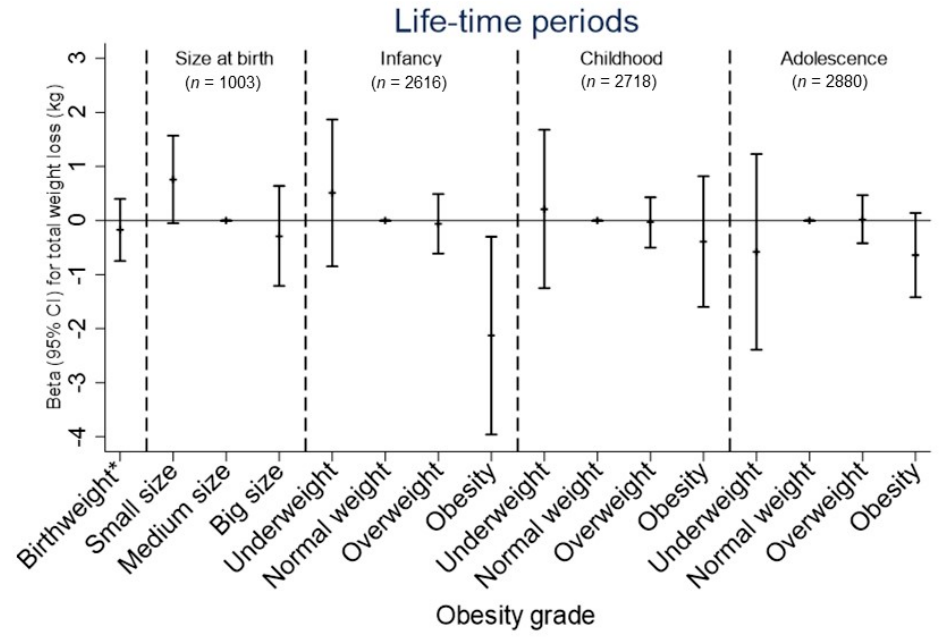
Figure 1. Associations between birth weight, size at birth, and personal life-course obesity grade with total weight loss (kg) in response to the intervention. Lines represent beta coefficient and 95% CI derived from linear regression models. All models adjusted for sex, age, nutritional clinic, year of assessment, and initial body weight. * For birth weight, the coefficient represents the change in total weight loss (kg) as continuous per 1 ‐ kg increase in birthweight. For size at birth, a medium size represents the reference category. For infancy, childhood and adolescence periods, a normal weight represents the reference category; p ‐ value for infancy obesity grade = 0.023.